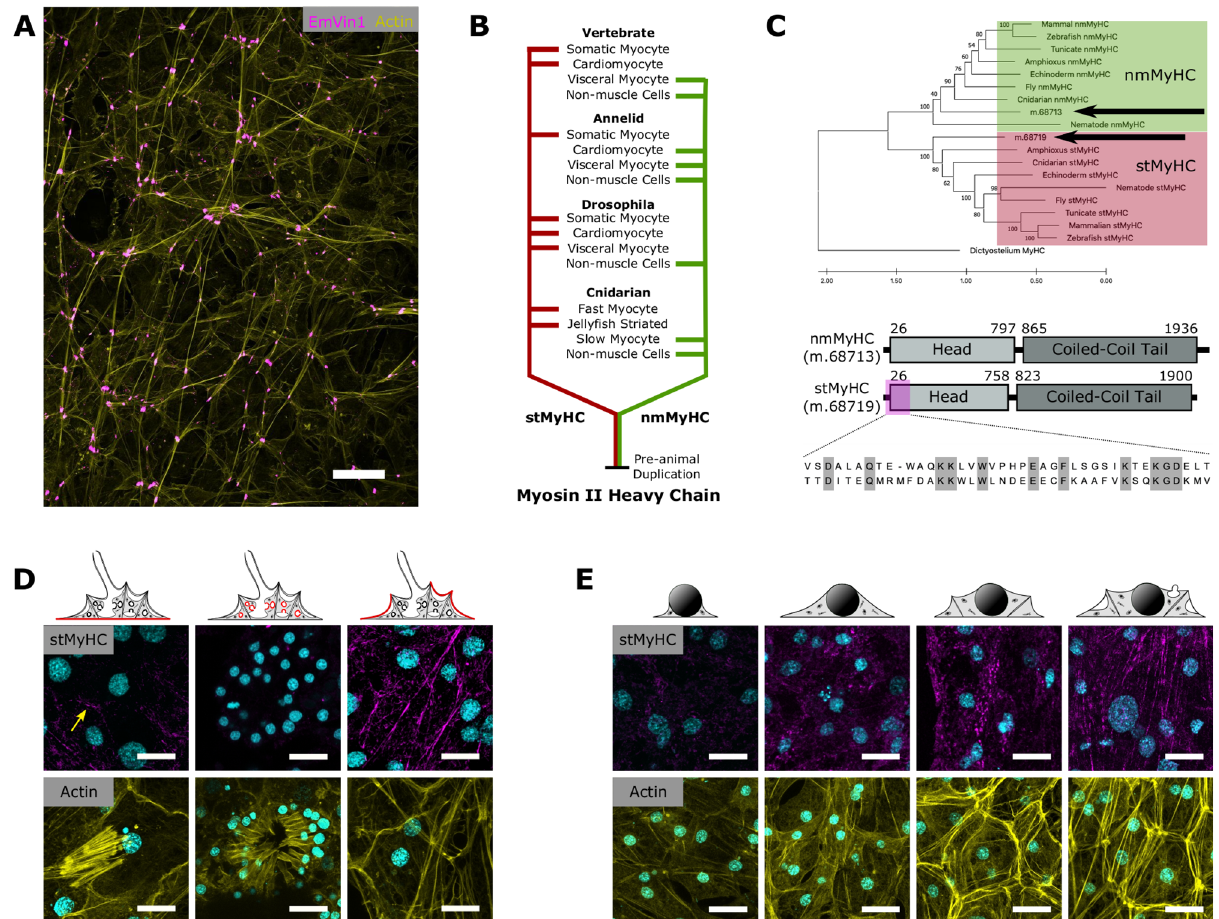
Fig. 2 Organization of actomyosin bundles. A Organization of actin-bundles (yellow) in incurrent tissues, with cell-junctions marked by vinculin staining (magenta) 71 . B Duplication and divergence of the Myosin II Heavy Chain. C The type II MyHC proteins found in E. muelleri (labeled with arrows) fall into either the stMyHC clade or nmMyHC clade. Phylogeny determined by the maximum likelihood method. Tree rooted with MyHC from Dictyostelium . Support values represent 1000 bootstrap iterations. Bottom panels show the basic structure of two type II MyHCs found in E. muelleri and the alignment of epitope region used to generate stMyHC antibody. D stMyHC immunostaining in the basopinacoderm (left), a choanocyte chamber (middle), and incurrent tissues (right). Samples were stained for DNA (magenta), stMyHC (cyan; top), and actin (yellow; bottom). Yellow arrow shows cell boundary staining in basopinacoderm. Immunostaings were performed on multiple sponges over three independent experiments with consistent results. E Developmental series of actin-bundles in incurrent pinacocytes stained for DNA (magenta), stMyHC (cyan; top), and actin (yellow; bottom). Immunostaining and phalloidin stainings were performed on multiple sponges over two independent experiments with consistent results. Scale bars 25 μ m in A and 10 μ m in D , E